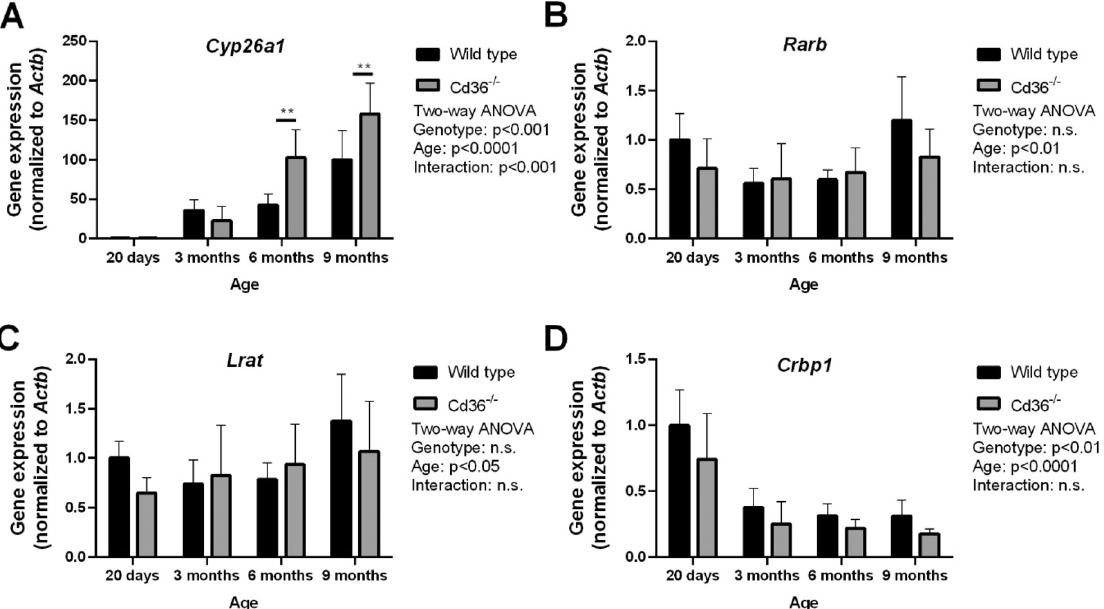
Figure 2. Hepatic gene expression levels of key mediators of vitamin A metabolism in aging wild type and Cd36 −/− mice. qPCR was used to determined relative hepatic gene expression levels of ( A ) Cyp26a1 , ( B ) Rarb , ( C ) Lrat , ( D ) Crbp1 . Data is shown as mean ± S.D. and significance determined by two-way ANOVA (n = 6 per group). *p < 0.05 denotes a significant post-test result between genotypes within mice of the same